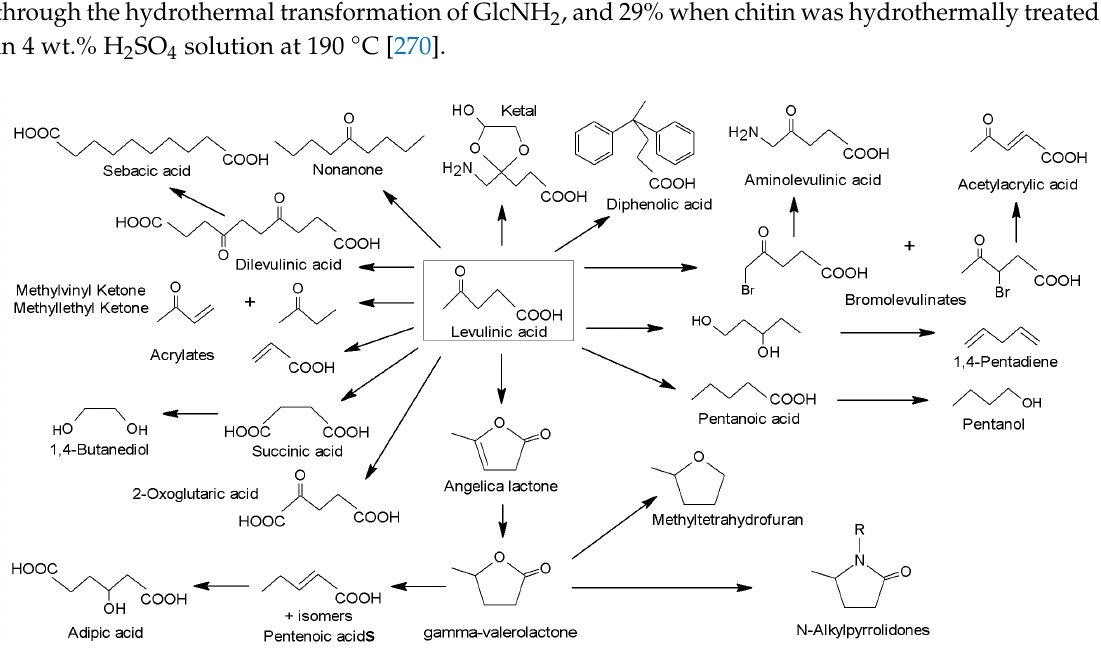
Figure 28. Scheme showing possible reactions of 5-hydroxymethylfurfural to obtain high value-added products.